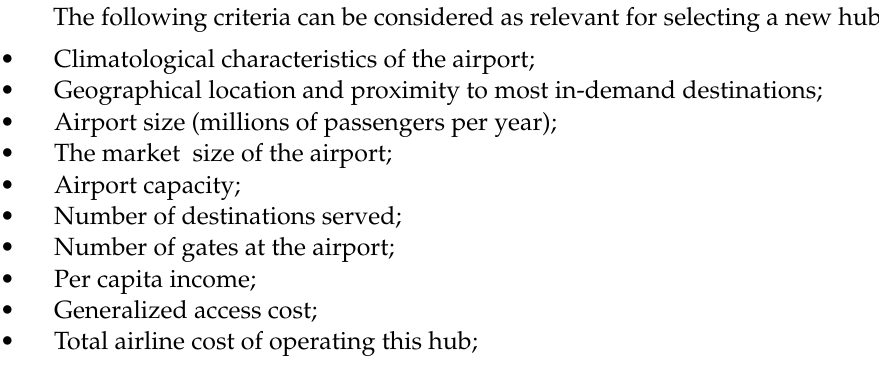
Figure 2. Average daily movement for the busiest European freighter